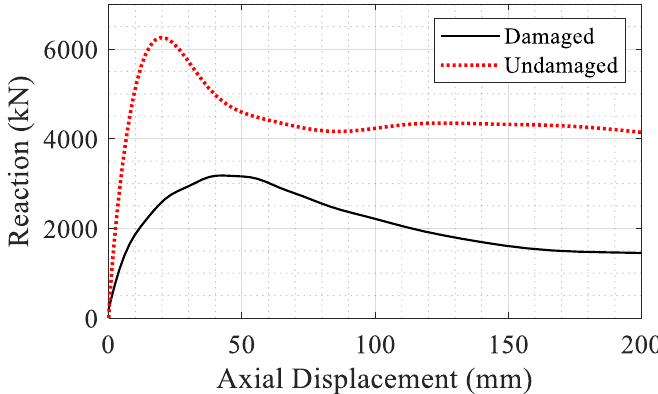
Figure 31. Comparison of axial capacity of the composite system with and without blast damage.